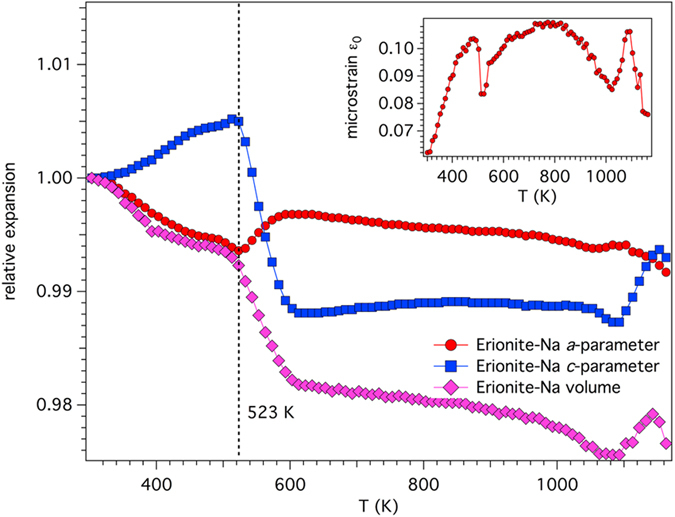
Relative expansion of cell parameters and volume of erionite-Na.Relative expansion of cell parameters (a/a303K and c/c303K) and volume (vol/vol303K) of erionite-Na. Inset: dependence of e0 microstrain on temperature.